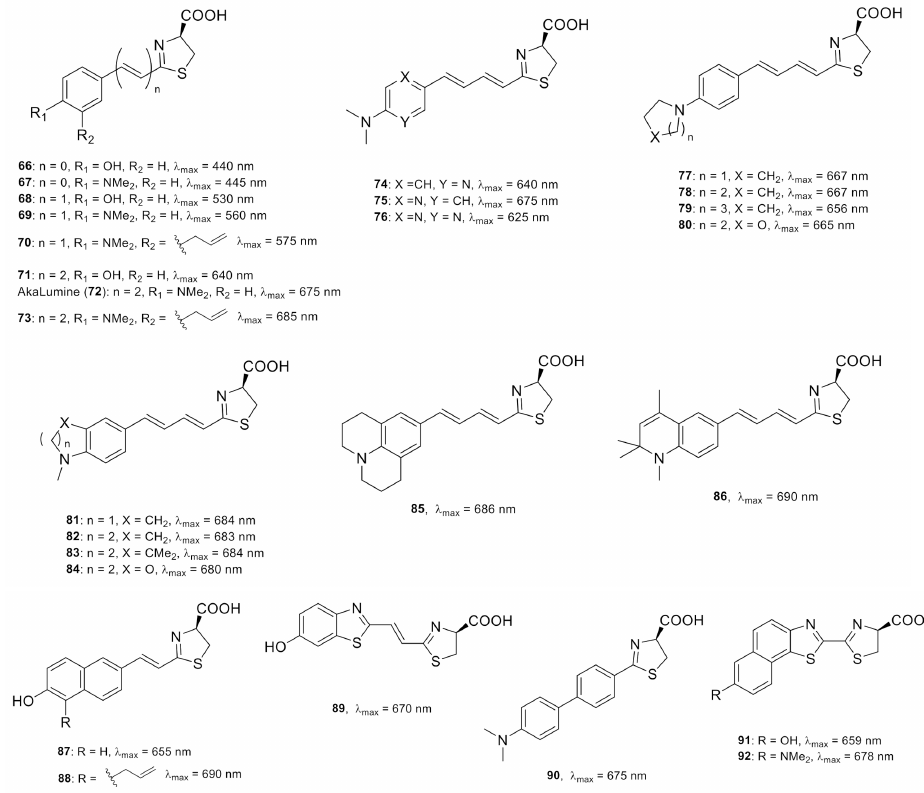
Figure 3. Chemical structures of substrates with elongated π -conjugated